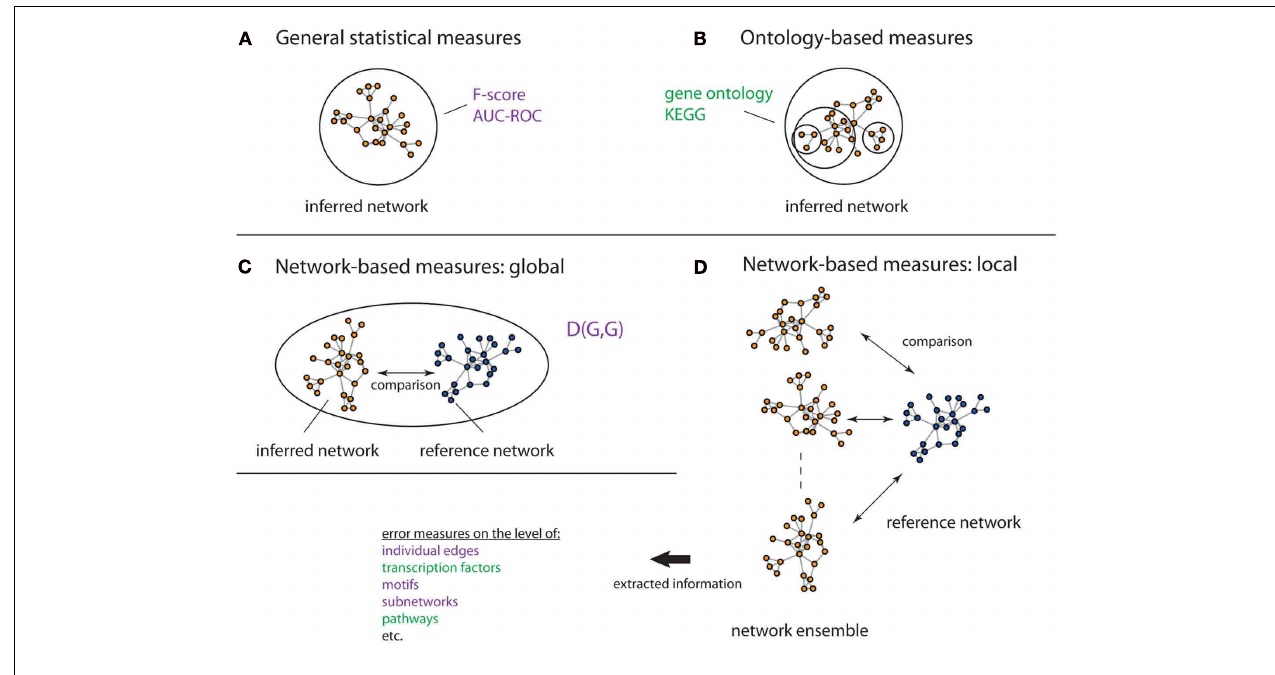
and local network-based measures (D) .The lack of any circle/oval in (D) shall indicate that there is no restriction to any particular resolution level. The measures in green incorporate biological information, whereas the measures in purple do